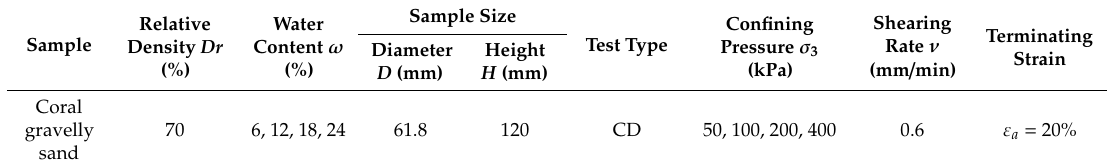
Table 2. Triaxial shear test scheme.